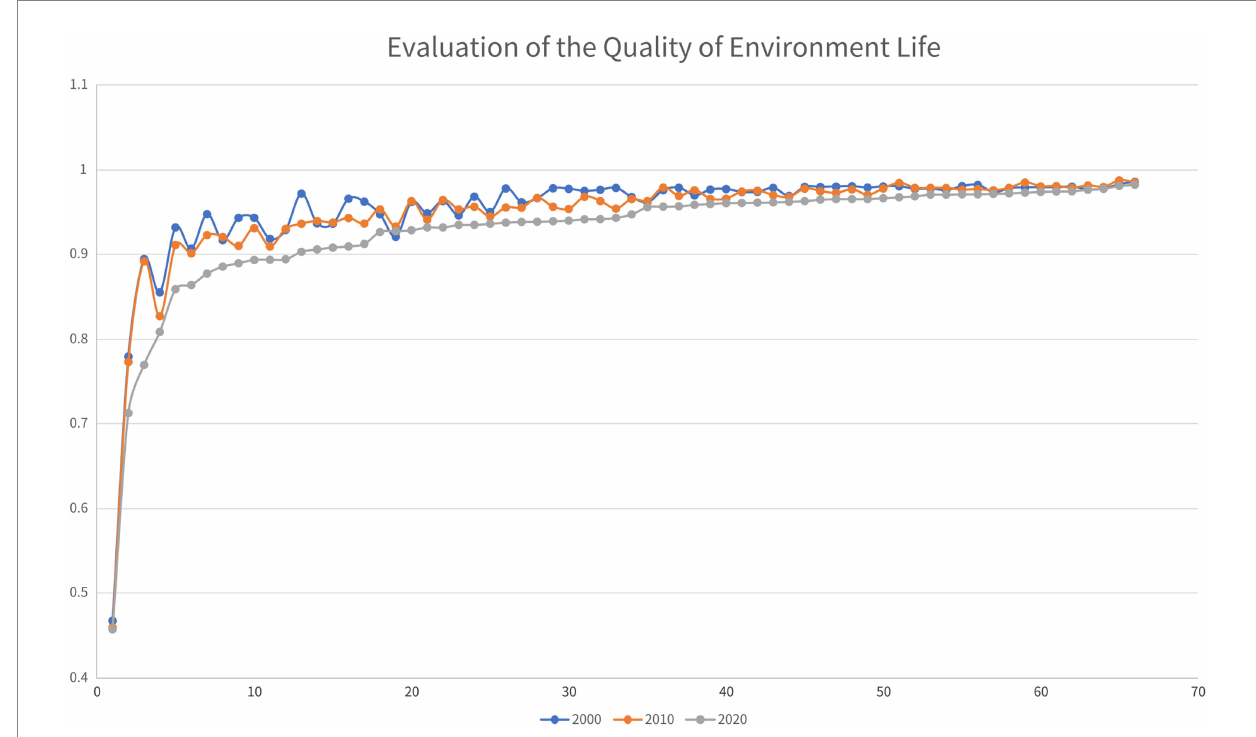
FIGURE 9 Analysis of the evolution of the environmental QoL of Guizhou’s districts and counties from 2000 to 2020.